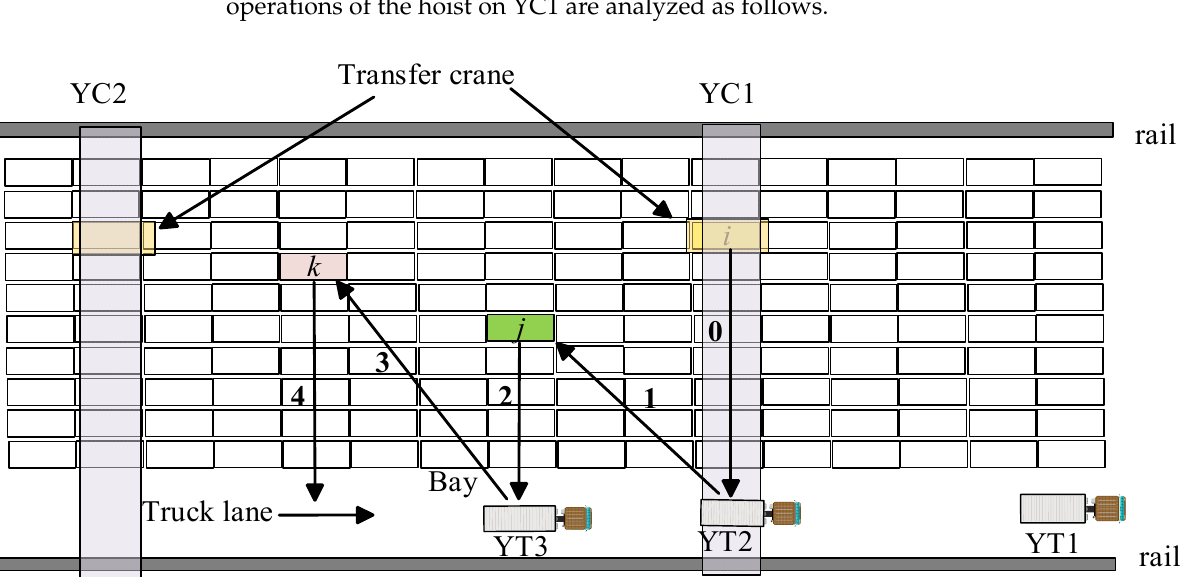
Figure 4. The movement of the hoist on the yard crane.